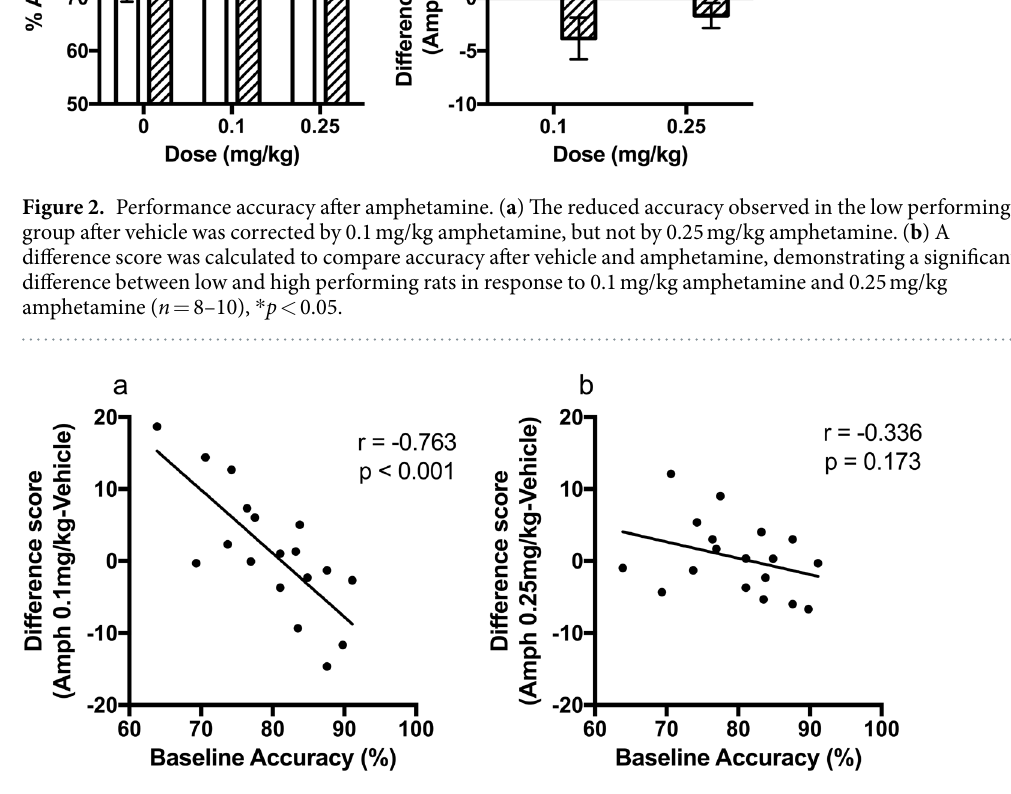
Figure 3. After adjustment for regression to the mean effects response to amphetamine was found to negatively correlate with baseline performance after ( a ) 0.1 mg/kg amphetamine ( r = − 0.763, p < 0.001) but not ( b ) 0.25 mg/kg amphetamine ( r = − 0.336, p = 0.173), ( N =